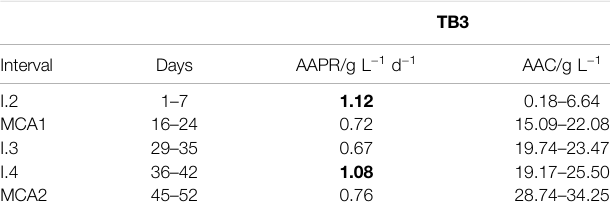
TABLE 3 | Calculated AAPRs over time intervals (I. and MCA) and corresponding AACs for